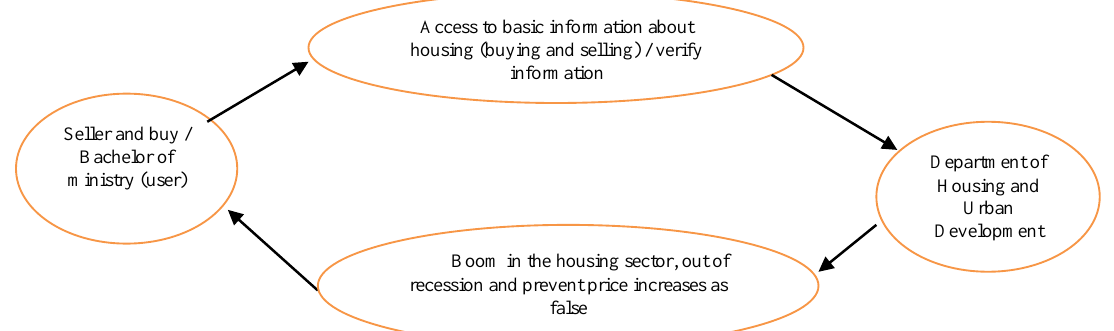
Figure2. Graph for the system of buying and selling real estate agent.